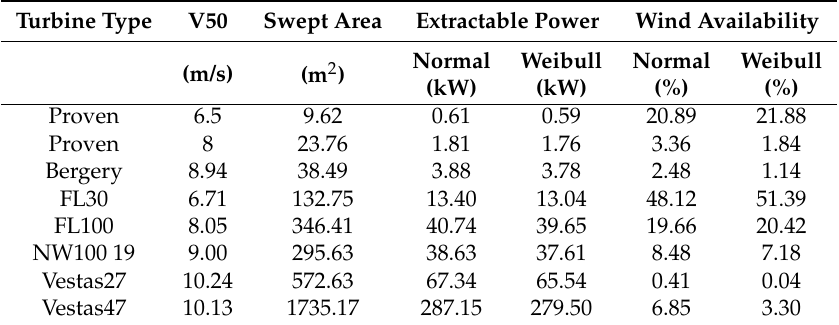
Table 6. Wind power and wind availability for selected wind power